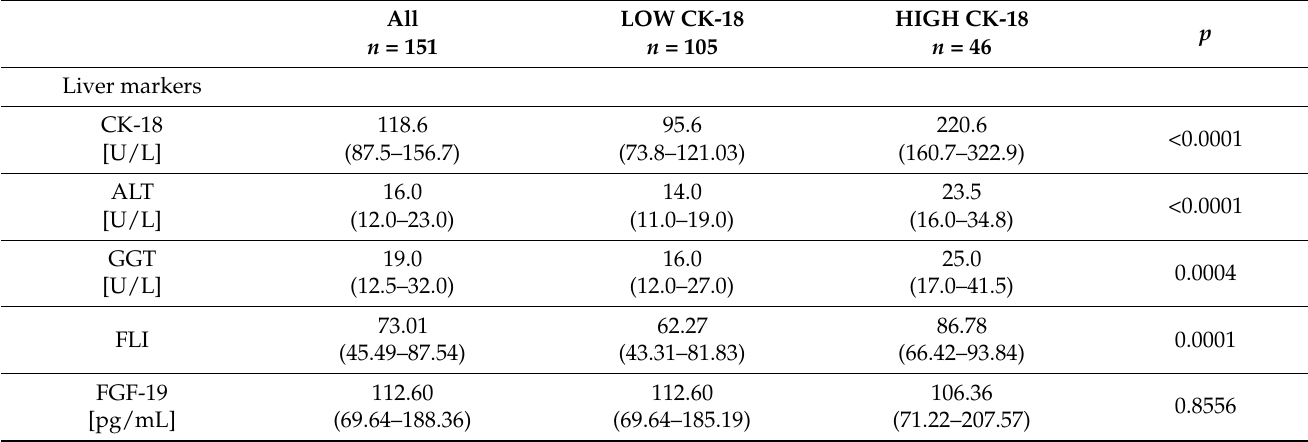
Table 2. Liver and inflammatory markers in groups according to the cytokeratin-18 plasma